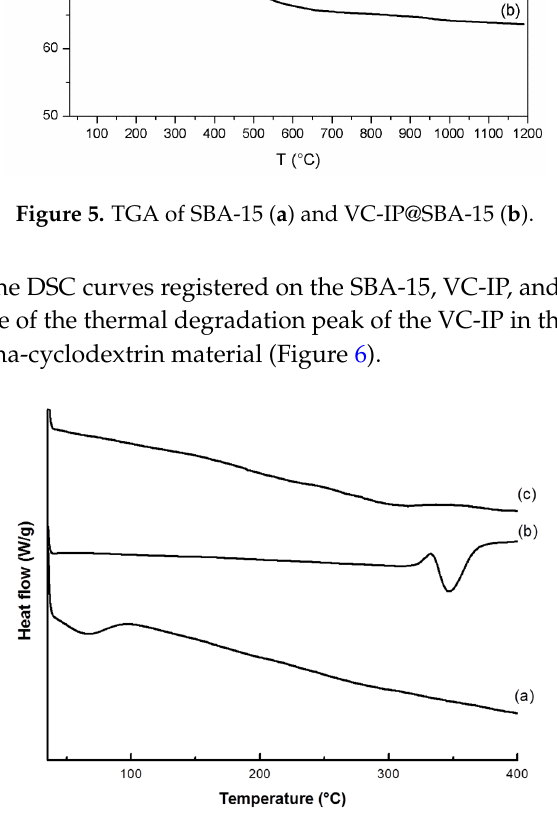
Figure 6. DSC curves of SBA-15 ( a ), VC-IP ( b ), and VC-IP@SBA-15 ( c ).